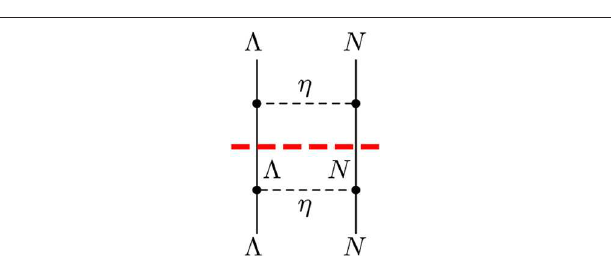
FIGURE 3 | Example of a planar box diagram. It contains an reducible part equivalent to the iteration of two one-meson exchange diagrams, as generated by the Lippmann-Schwinger equation. Additionally it contains a genuine irreducible contribution that is part of the effective potential.